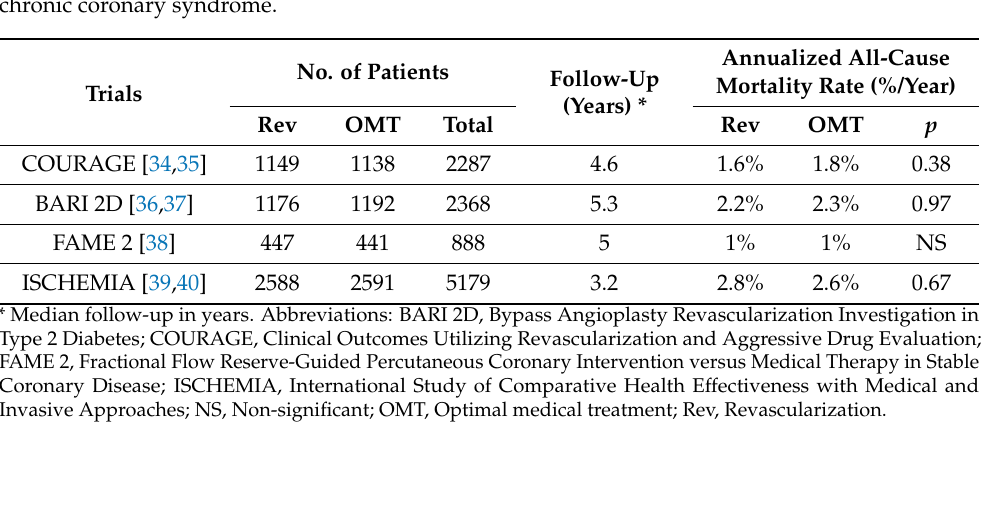
Table 2. All-cause mortality in the main trials comparing medical treatment plus revascularization (percutaneous coronary intervention (PCI) or CABG) vs. medical treatment alone in patients with chronic coronary